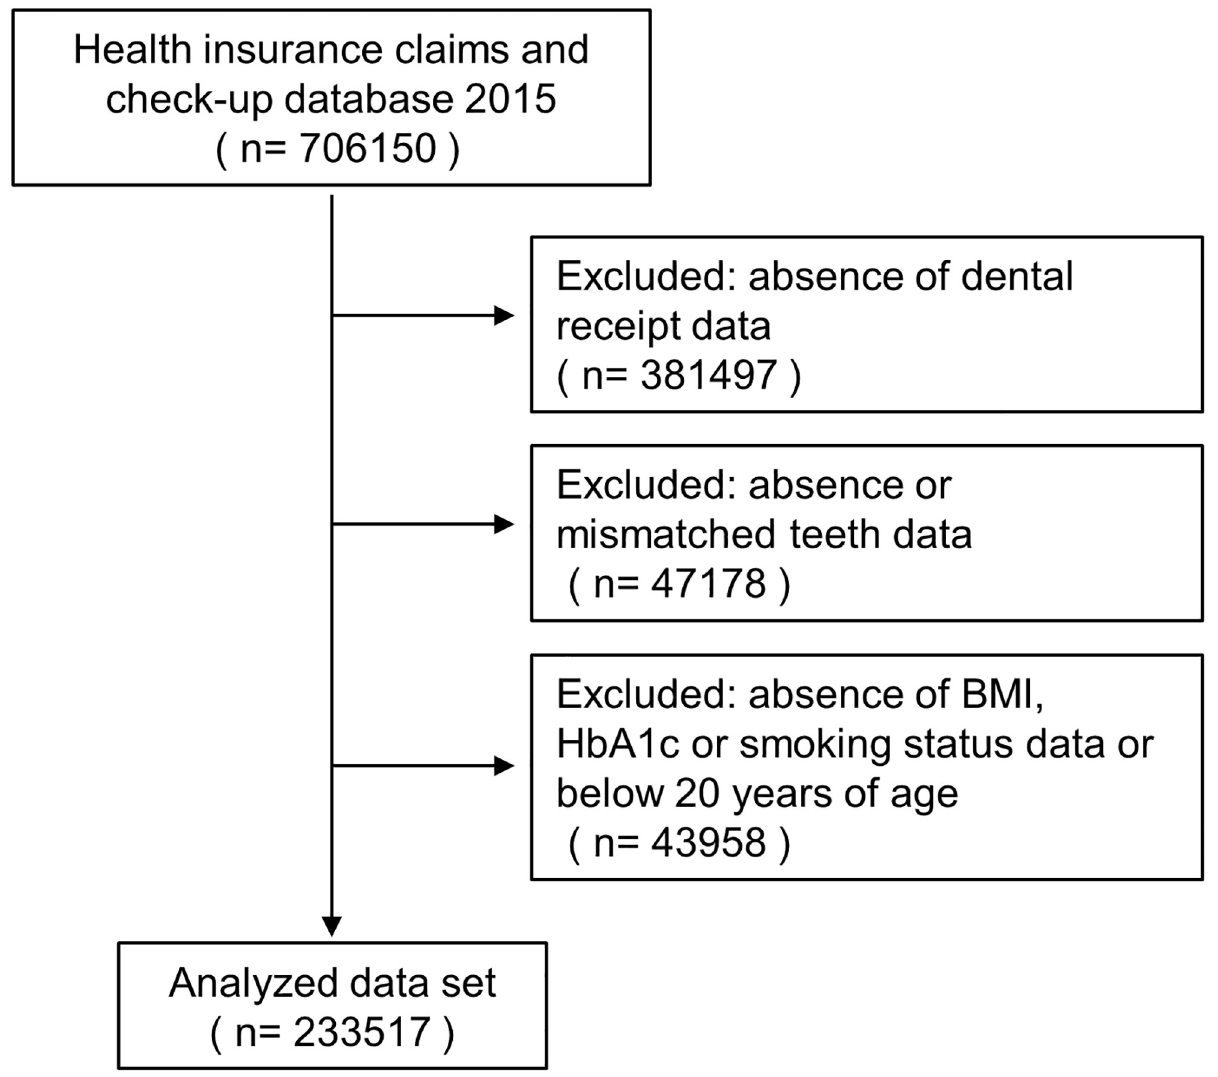
Fig 1. Flowchart of the inclusion and exclusion of subjects in the health insurance claims and check-up database of 2015 provided by MinaCare Co., Ltd.